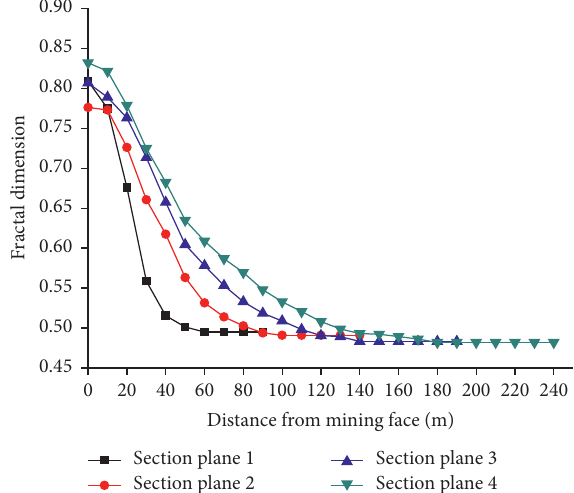
Figure 7: Fractal dimension of fractures in the coal seam in the vertical section